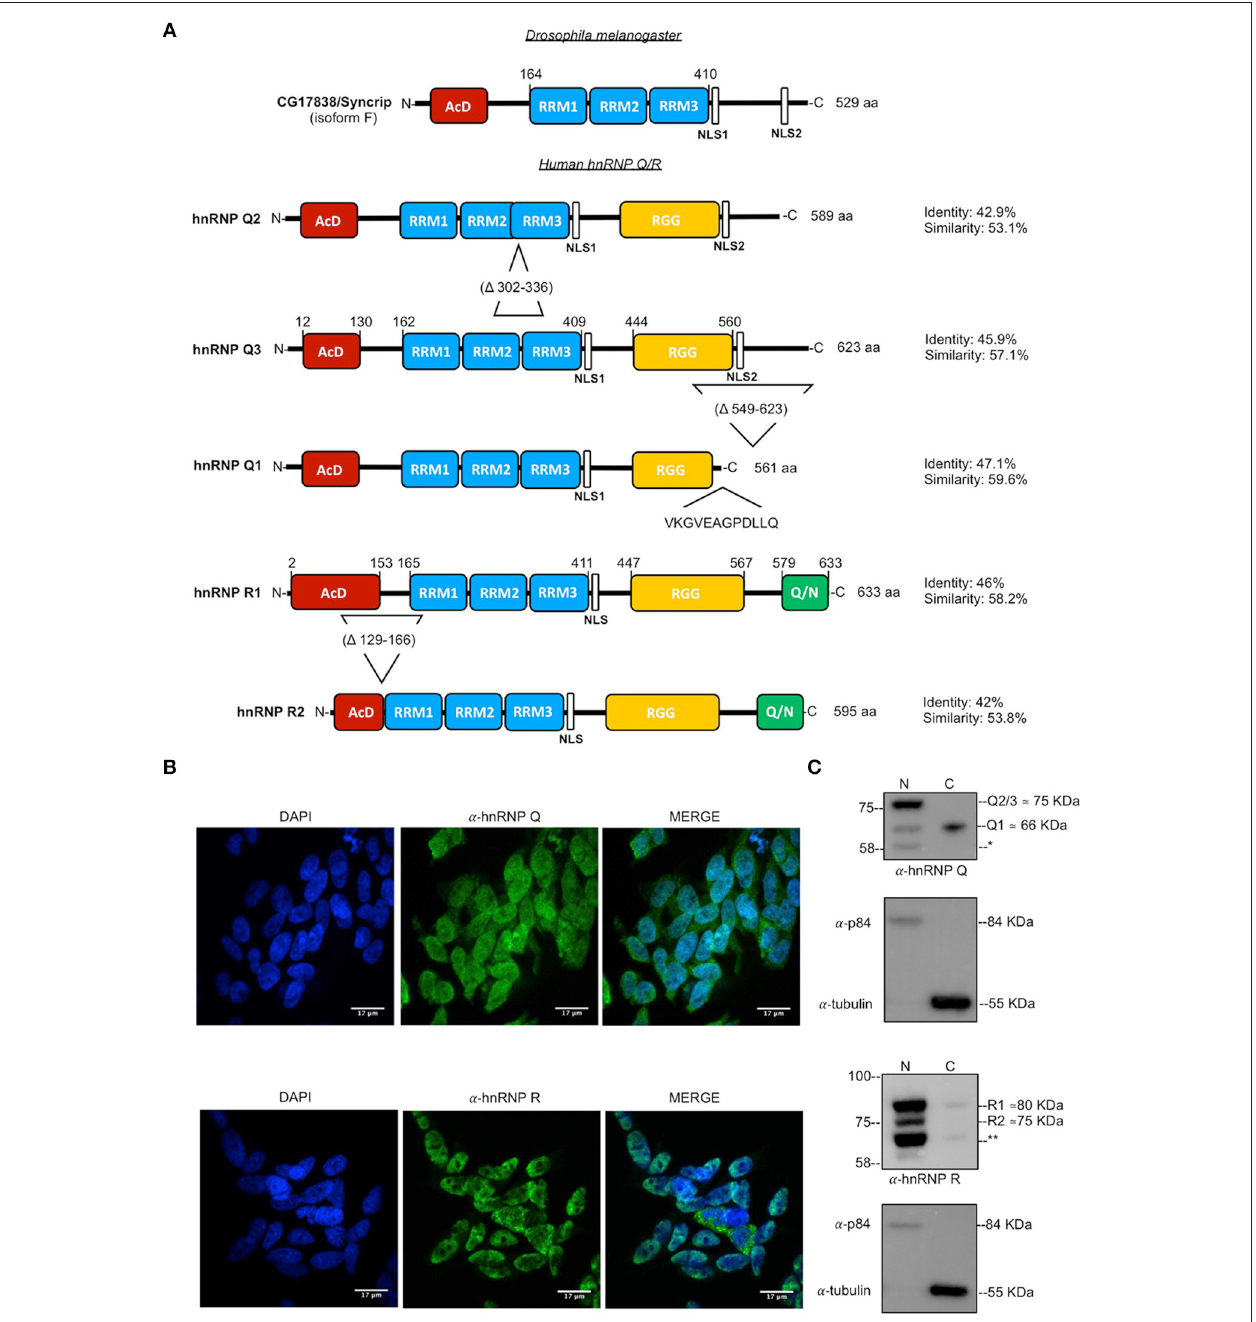
FIGURE 1 | Structure of and subcellular localization of endogenous hnRNP Q and hnRNP R. (A) Schematic representation of protein domains and major isoforms of Drosophila melanogaster CG17838/Syncrip and human hnRNP Q/ hnRNP R. AcD (acidic domain), RRM (RNA-recognition motif), NLS (nuclear localization signal), RGG (Arg-Gly-Gly)-box and Glutammine/Asparagine (Q/N)-rich domain are highlighted in colored boxes; relative sequence position and amino acids length of each isoform is also reported. Drosophila melanogaster CG17838/Syncrip isoform F contains a conserved AcD, three RRM (RRM1, RRM2, and RRM3) and two NLS. Regarding hnRNP Q three major isoforms are represented: hnRNP Q3 is the longest variant and contains an AcD domain, three RRMs, two NLS and an RGG-box; hnRNP Q2 lacks of 36 aa ( 1 302-336) between RRM2 and RRM3 compare to the longest variant hnRNP Q3, while hnRNP Q1 lacks of the second NLS and RGG-box region ( 1 549-623) from hnRNP Q3 and contains a unique C-terminal domain (VKGVEAGPDLLQ). The isoform 1 of hnRNP R (hnRNP R1) contains an AcD domain, three RRMs, two NLS, an RGG-box and a Q/N-rich domain at C-terminus. The low expressed and neuronal-specific isoform (hnRNP R2) lacking of the 41 aa ( 1 129-166) between the AcD domain and the first RRM is also reported. Sequence identity and similarity were calculated using EMBOSS Needle with respect to the Drosophila melanogaster CG17838/Syncrip isoform F. We considered this fly isoform, according to its high expression in different stage of life cycle and in all adult